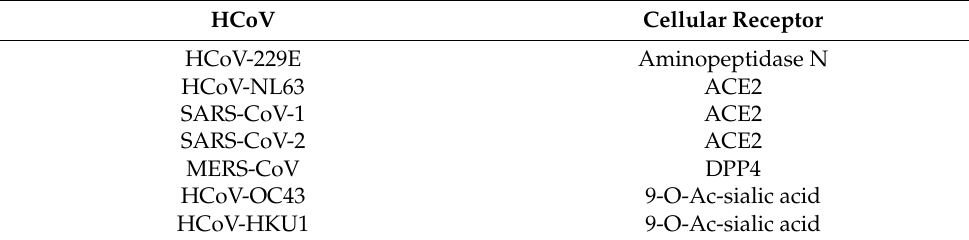
Figure 2. The genomic organization of the seven human coronaviruses: all coronaviruses encode two major Open Reading Frames (ORFs) known as ORF1a and ORF1b in addition to Spike (S), Envelope (E), Membrane (M) and Nucleocapsid (N) proteins. S proteins form trimeric envelope glycoproteins utilized for entry after receptor binding, whilst other surface proteins (E and M) have roles in viral assembly. All HCoVs also encode a variable set of non-structural proteins (shown in grey), and the two seasonal betacoronaviruses HCoV-HKU1 and HCoV-OC43 additionally encode surface Haemagglutinin-Esterase (HE) proteins as receptor-destroying enzymes. Table 1. Receptor usage varies between human